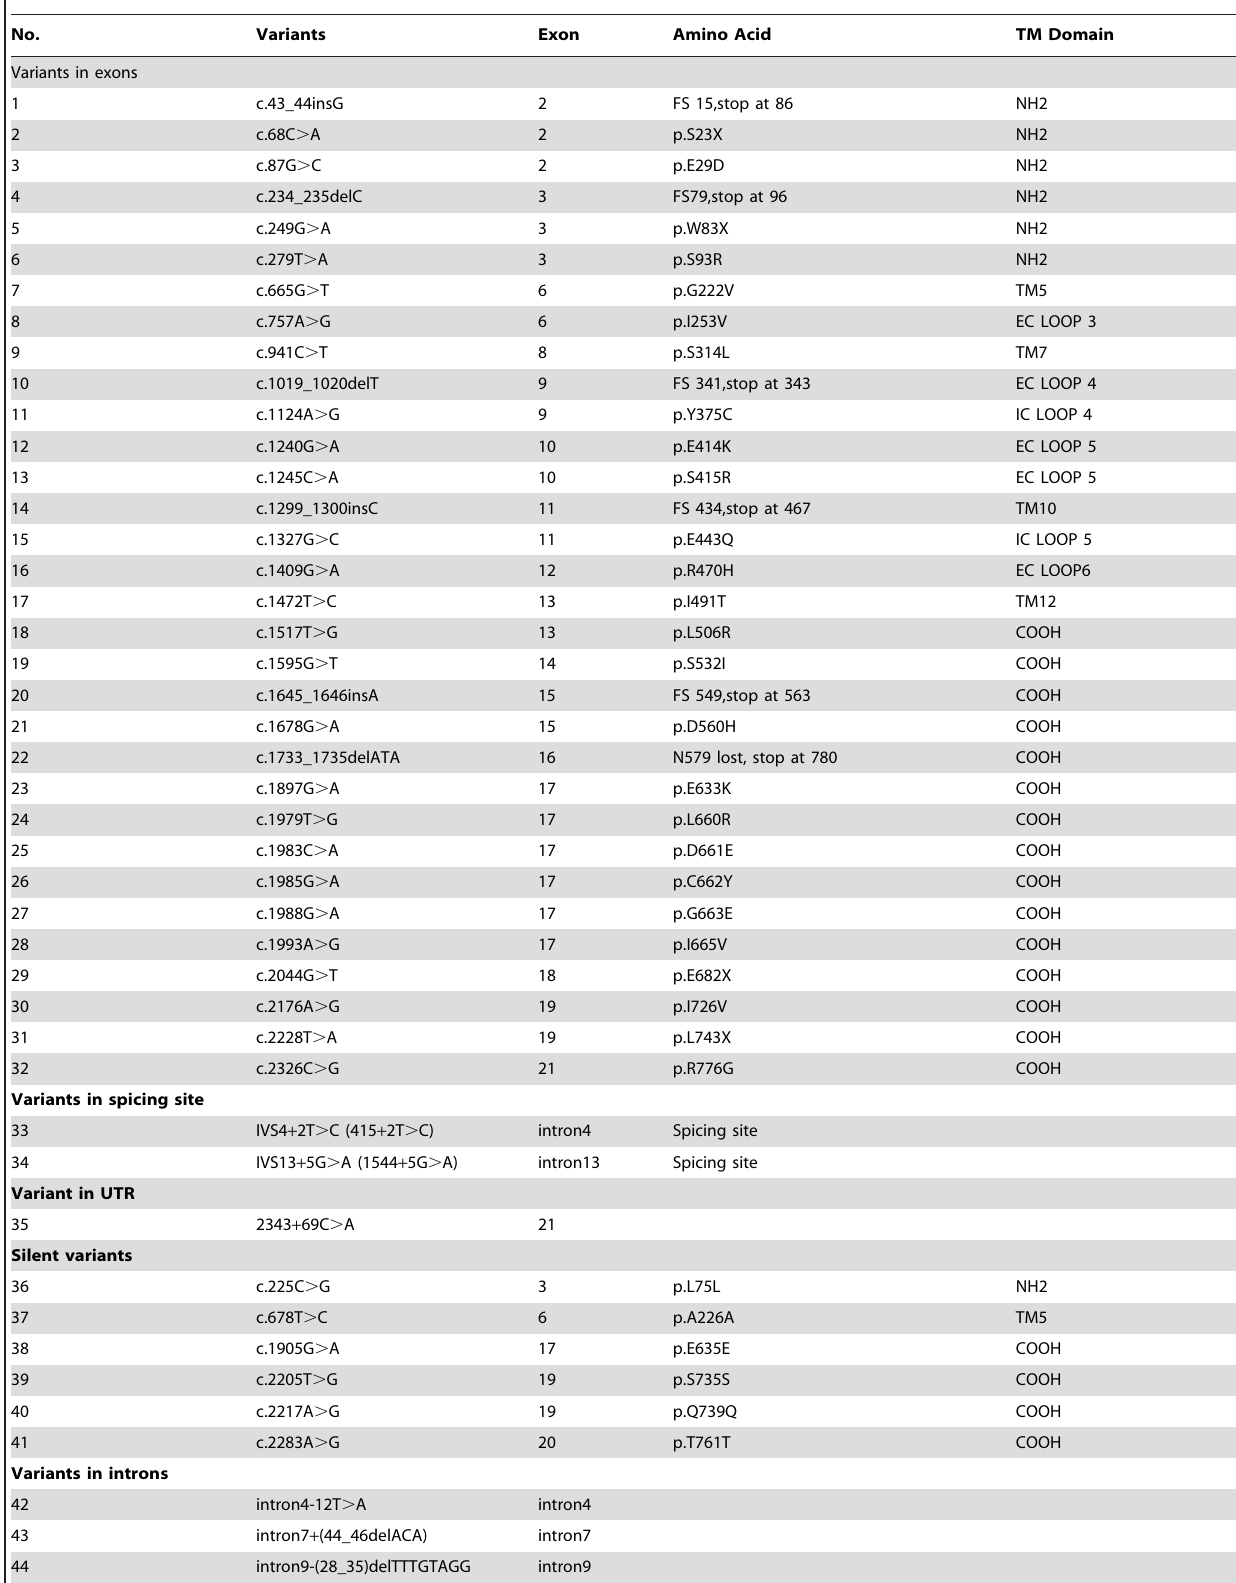
Table 2. Novel SLC26A4 variants found in Chinese hearing loss